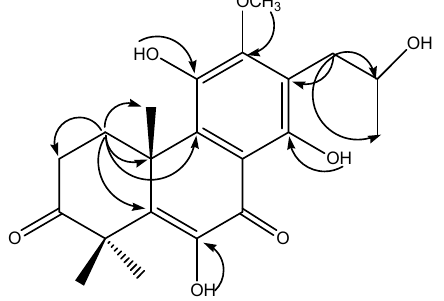
Figure 2. Key HMBC correlations for compound 8 .